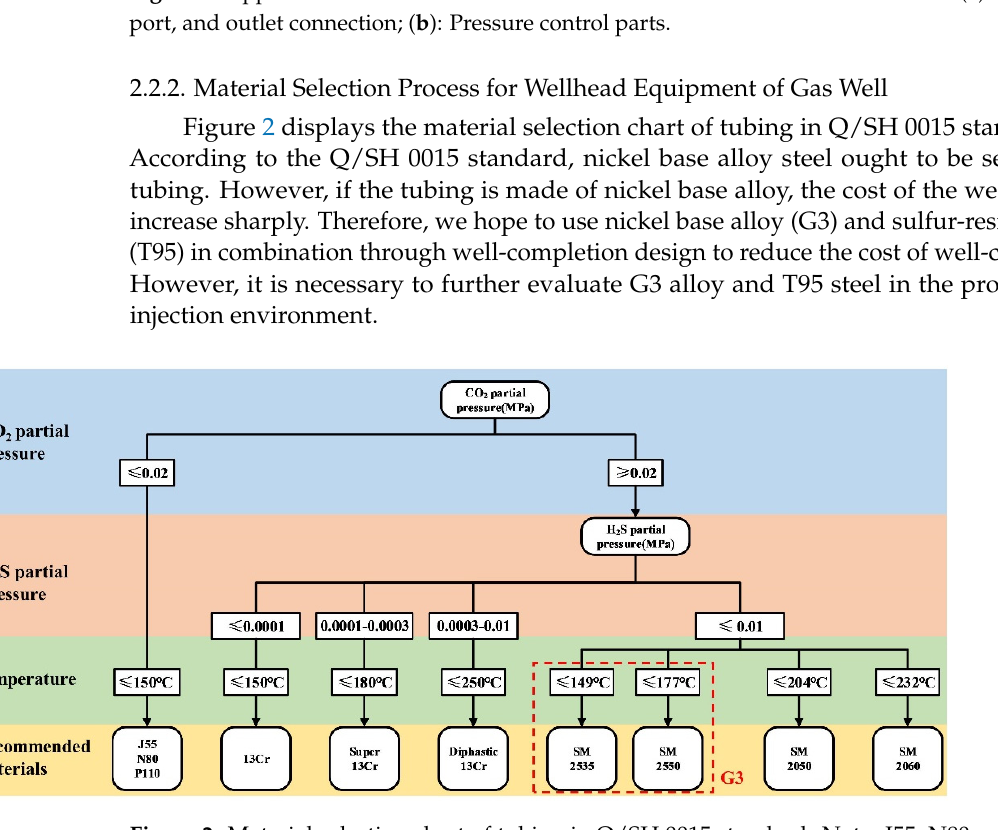
Figure 2. Material selection chart of tubing in Q/SH 0015 standard. Note: J55, N80, and 13Cr are widely used in the oil industry. SM2535 represents UNS N08535, SM2550 represents UNS N07750, and G3 represents UNS N06985. All materials adopt Q/SH 0015-2006 standard and API Specification 5CT or ISO 11960 2014